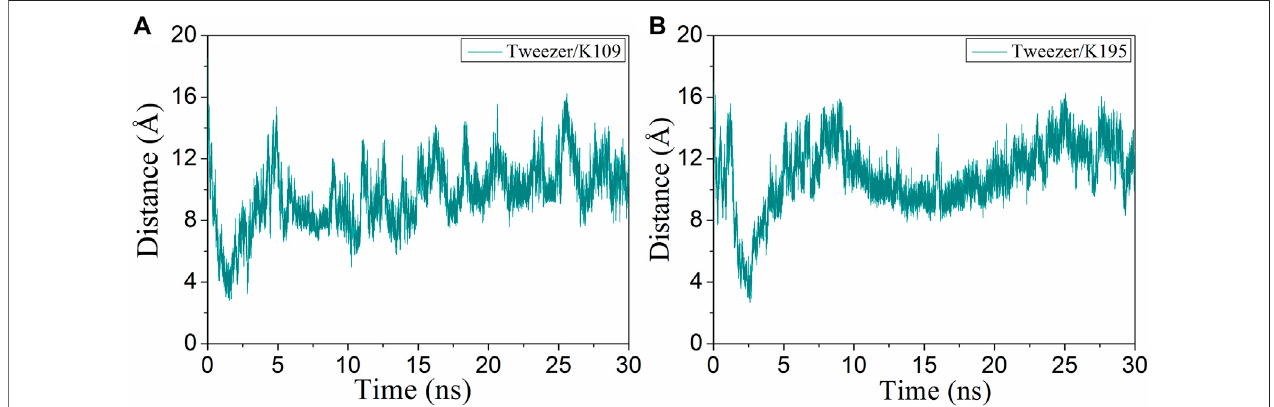
FIGURE 5 | Evolutions of the distance (CV1) of the binding of the tweezer to (A) K109 and (B) K195 with respect to the simulation time.